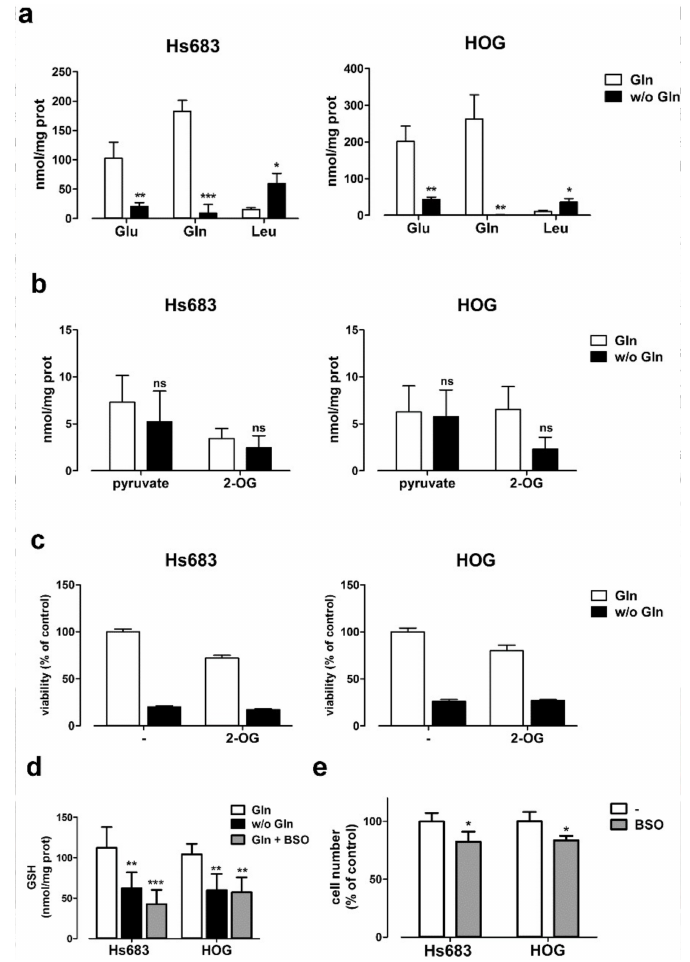
Figure 3. Oligodendroglioma cell viability does not correlate with changes in anaplerotic substrates or GSH. ( a , b ) Cell contents of Glu, Gln, and Leu ( a ) or of pyruvate and 2-OG ( b ) were measured in Hs683 and HOG cells incubated for 19 h in the presence (Gln, 4 mM) or in the absence ( w / o Gln) of Gln. Data are expressed as nmol/mg protein. Means ± SD of three experiments are shown. * p < 0.05, ** p < 0.01, *** p < 0.001, ns, not significant, as assessed with one-way ANOVA. ( c ) Viability of Hs683 and HOG cells incubated for 48 h in the presence (Gln) or in the absence ( w / o Gln) of Gln (4 mM), with or without a membrane-permeant form of 2-OG (dimethyl-2-oxoglutarate, 8 mM). Means ± SD of three experiments, with three independent determinations each, are shown. ( d ) The cell content of reduced GSH in Hs683 and HOG cells incubated for 19 h in the presence (4 mM) or in the absence of Gln ( w / o Gln). Data are expressed as nmol/mg protein. Means ± SD of three experiments are shown. ** p < 0.01, *** p < 0.001, ns, not significant, as assessed with one-way ANOVA. ( e ) Viability of Hs683 and HOG cells treated for 48 h with BSO (1 mM). Means ± SD of three experiments, with three independent determinations each, are shown. * p < 0.05, as assessed with student t test for unpaired